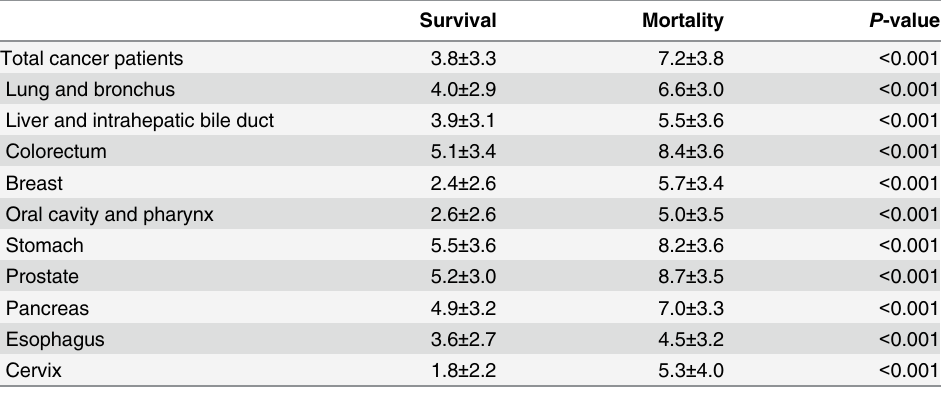
Table 3. The average adjusted-AACI score for those who live beyond 90 days and for those who died prior to 90 days, Mean ± SD, n =